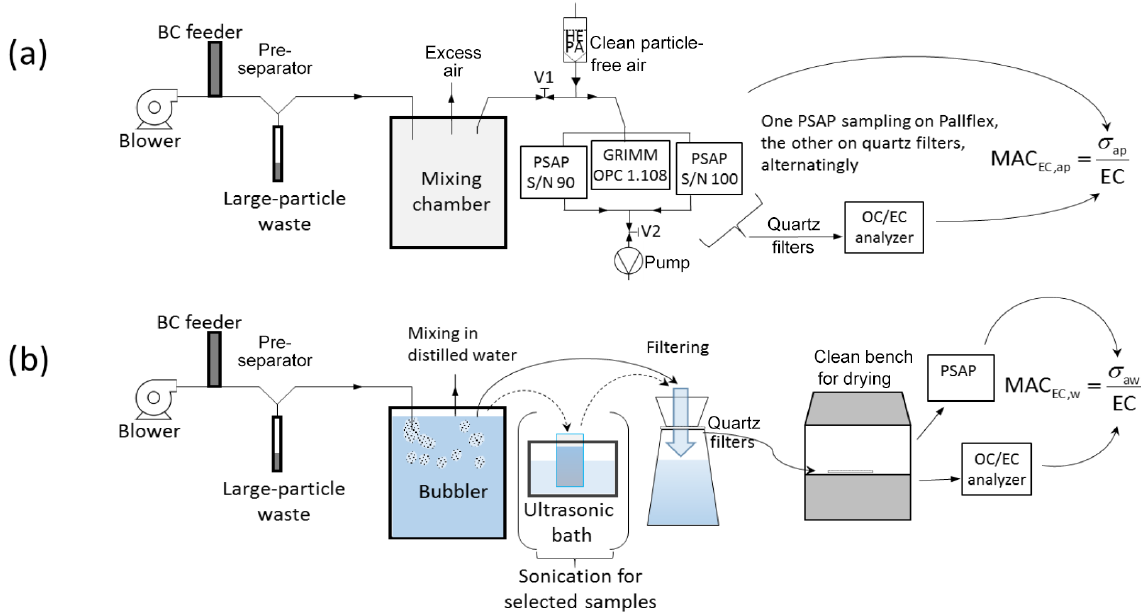
Figure 1. Experimental setup for the airborne (a) and for the liquid (b)